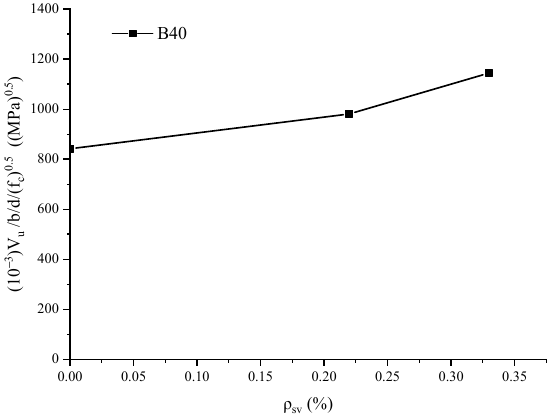
Figure 15. Effect of stirrup reinforcement ratio ρ sv on the normalized ultimate shear capacity V u .